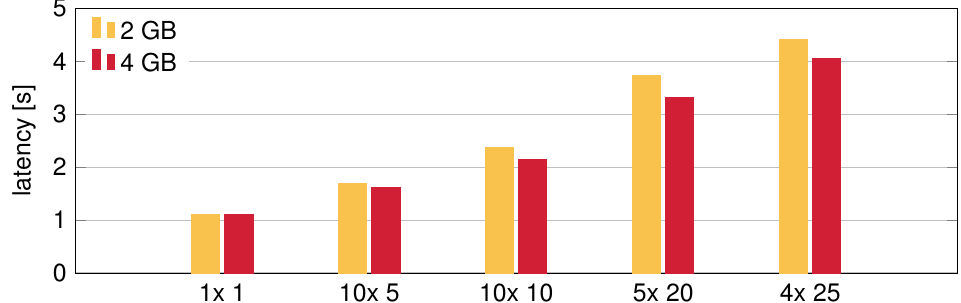
Figure 9. Processing latencies for different task distributions on nodes with 2 GB and 4 GB of RAM. (Declaration: <no. of nodes> x <no. of parallel